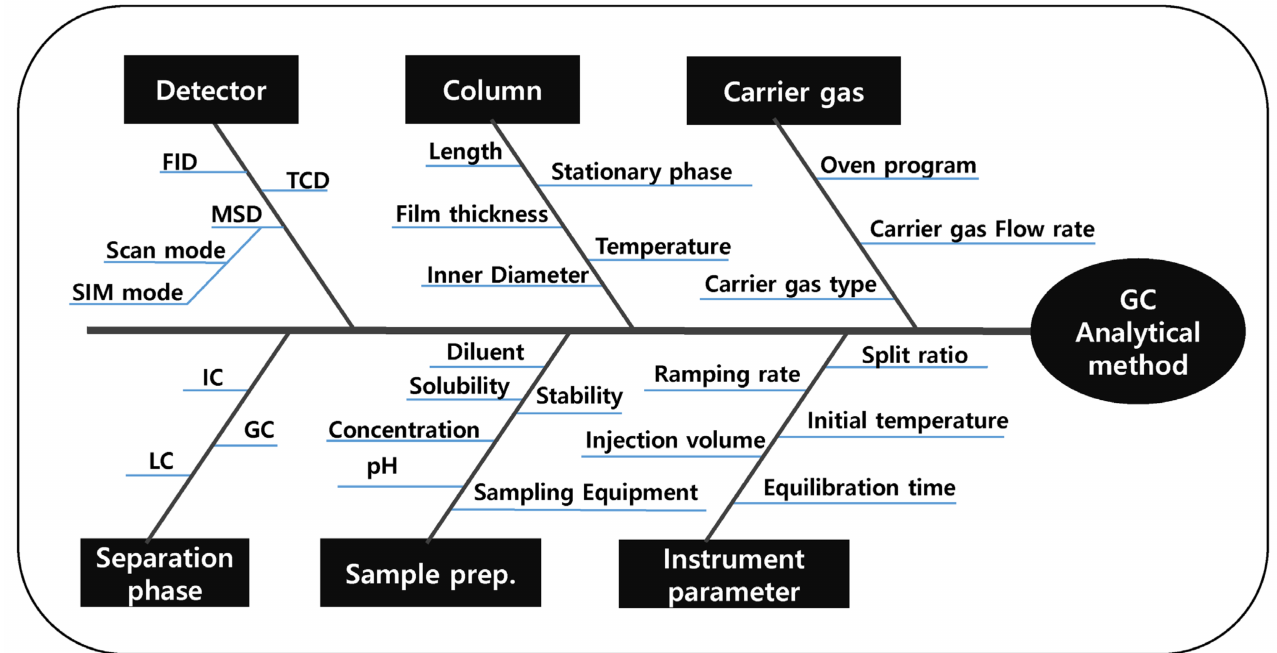
Figure 2. Fishbone